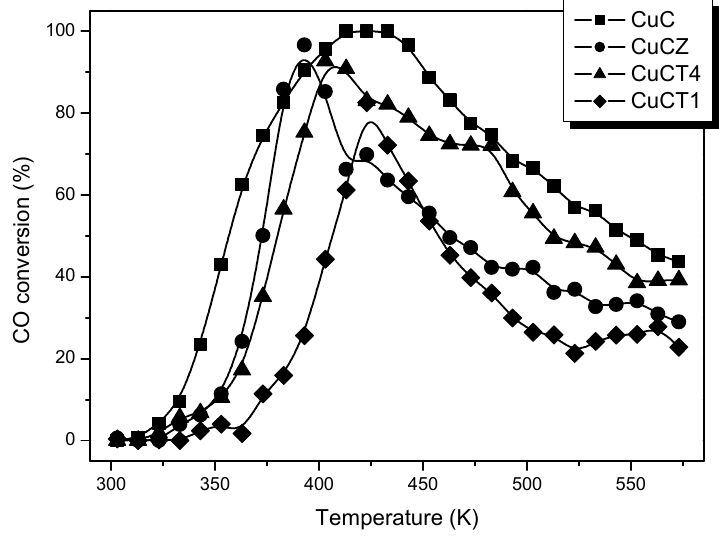
Figure 3. Profiles of CO conversion (top) and selectivity for the CO-PROX process (bottom) obtained during catalytic tests under 1% CO + 1.25% O for the indicated catalysts. Note: This figure is adapted with permission from